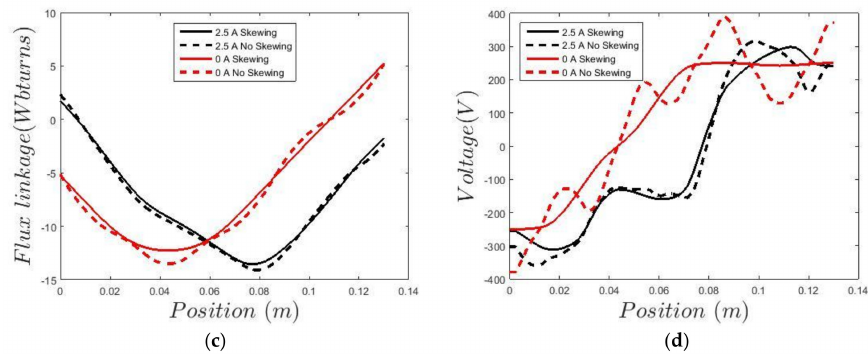
Figure 10. Characteristics of the generator both for the skewed and the non-skewed case for no-load and a current density of 2.5 A: ( a ) The damping force vs. position over one pole length; ( b ) The average damping force over one pole vs. current; ( c ) The flux linkage vs. position over one pole length; and, ( d ) The voltage vs. position over one pole length, where the no-load voltage is trapezoidal rather than sinusoidal.